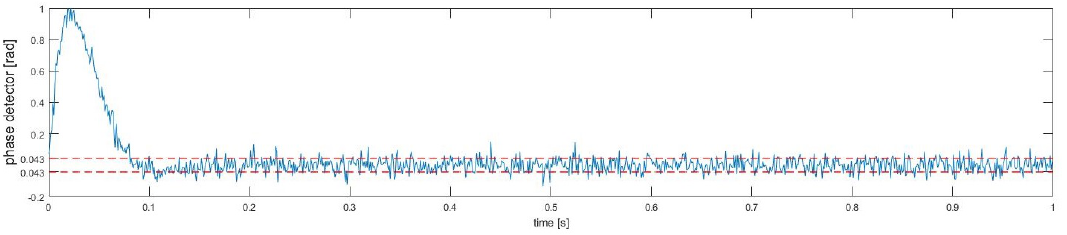
Figure 12. Output of phase